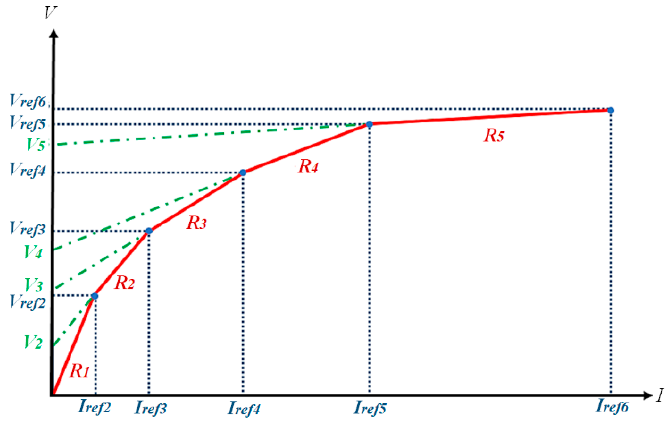
Figure 4. Five-segment piece-wise approximation of a nonlinear v-i characteristic curve [11].